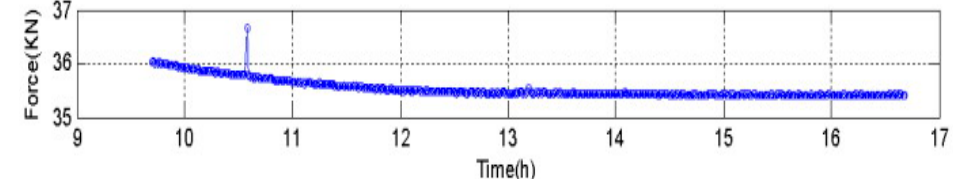
Figure 9. The pretightening force of the bolt when the initial force is 30% of the yield strength and the excitation frequency is 6 Hz.